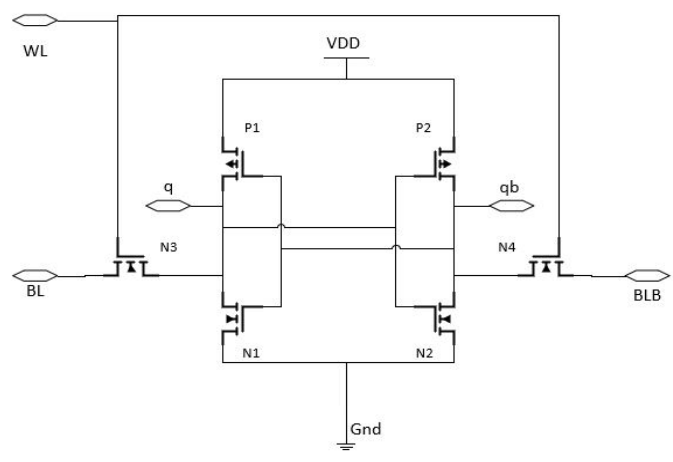
Figure 5. Implementation of 6T–CMOS Static RAM (SRAM) design [8].